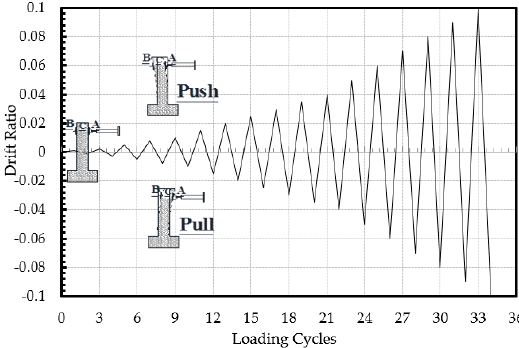
Figure 4. Loading protocol used for the cyclic tests.